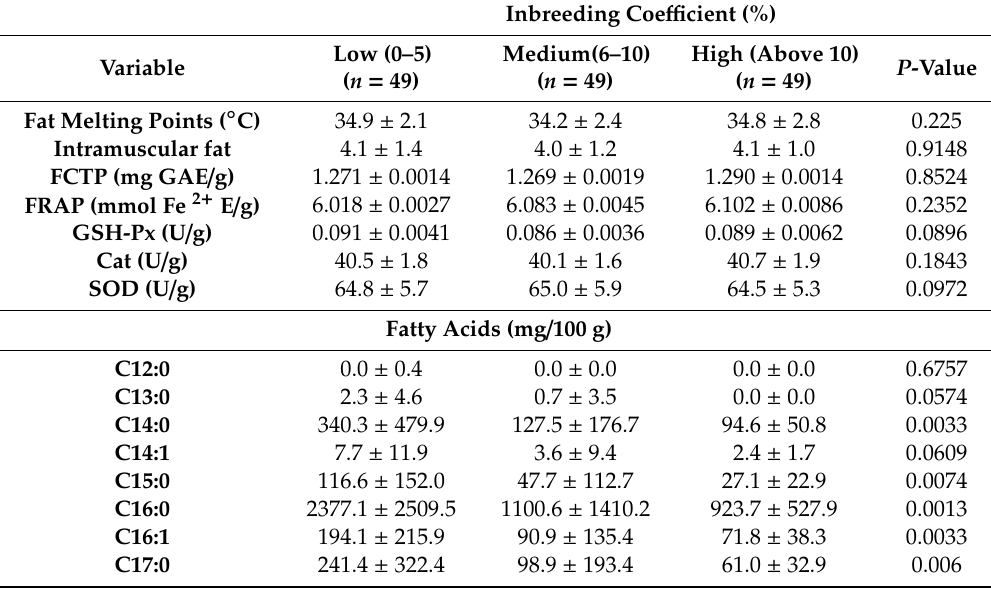
Table 4. E ff ect of inbreeding coe ffi cients (Means ± s.d.) on fat melting point, intramuscular fat, fatty acids, antioxidant phenolics and enzyme activities in the Longissimus dorsi muscle of ryegrass-fed TAW lambs 1